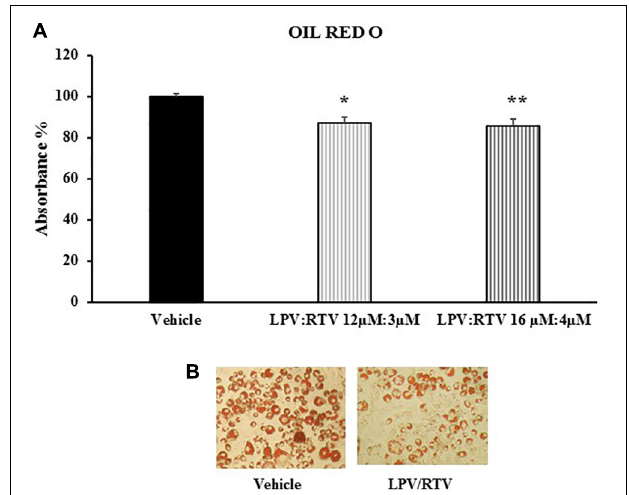
FIGURE 2 | Effect of LPV:RTV treatment on lipid accumulation. Fully differentiated 3T3-L1 cells were treated as indicated in Figure 1 . The intracellular lipids were stained with Oil Red O; the absorbance was measured at 520 nm. Absorbance was calculated as percent of that measured in vehicle group. Results are expressed as mean ± SEM and represent the mean of 18 determinations obtained in three independent experiments. ∗ p < 0.05 and ∗∗ p < 0.01 vs. vehicle (A) . Representative images for each treatment are shown (B) .